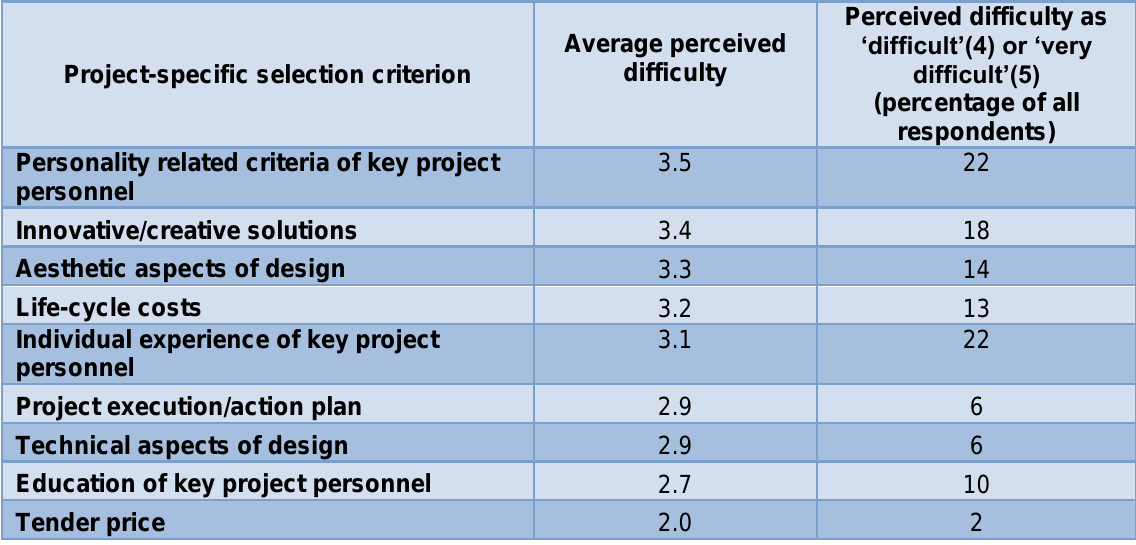
Table 5 Perceived difficulty to evaluate selection